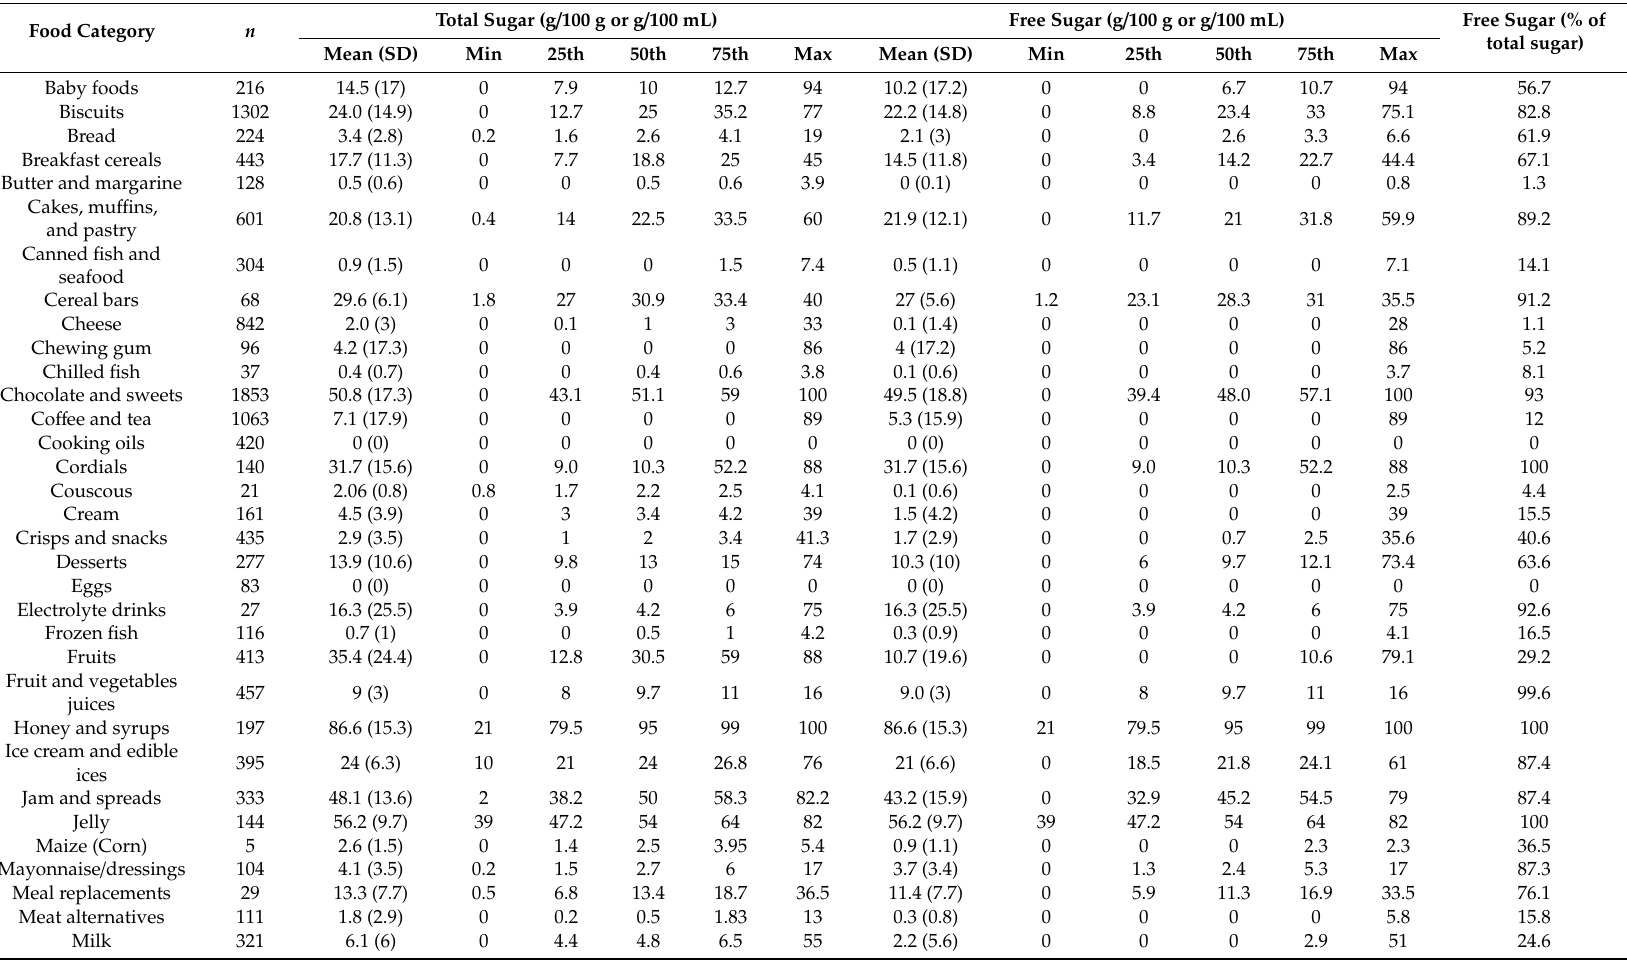
Table 1. Total and free sugar content (g / 100 g or g / 100 mL) of pre-packaged food products divided by food categories (2017 data, Slovenia). Mean values, SD, quartiles (min, 25th, 50th / median, 75th, max), and mean free sugar as a proportion of total sugar are shown for each